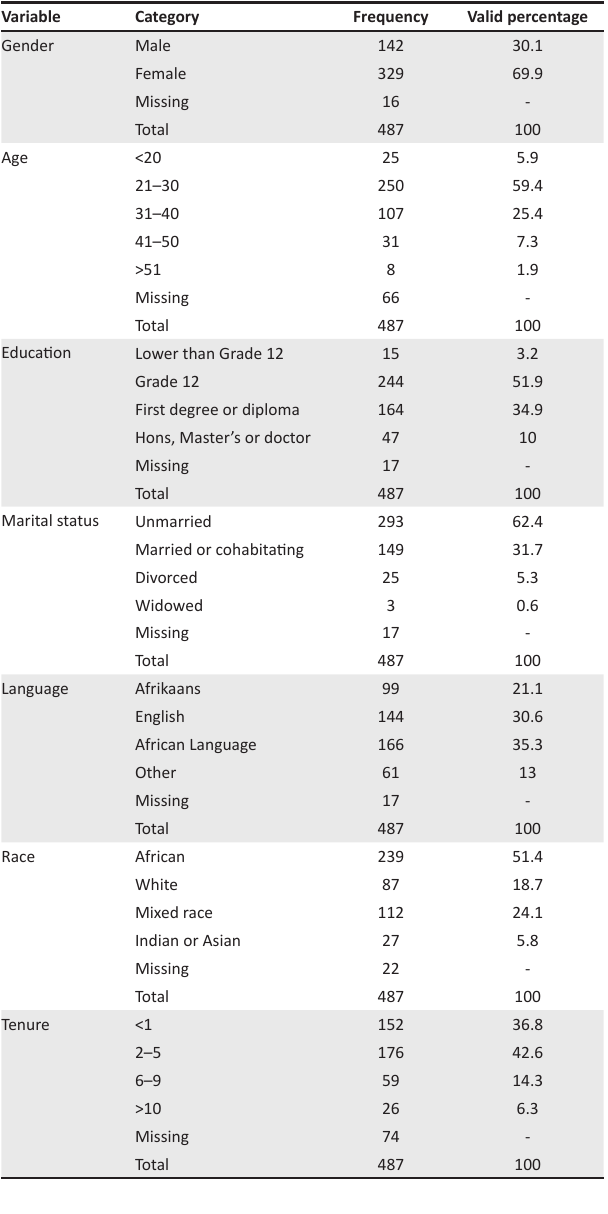
TABLE 1: Biographic and demographic details of the sample.